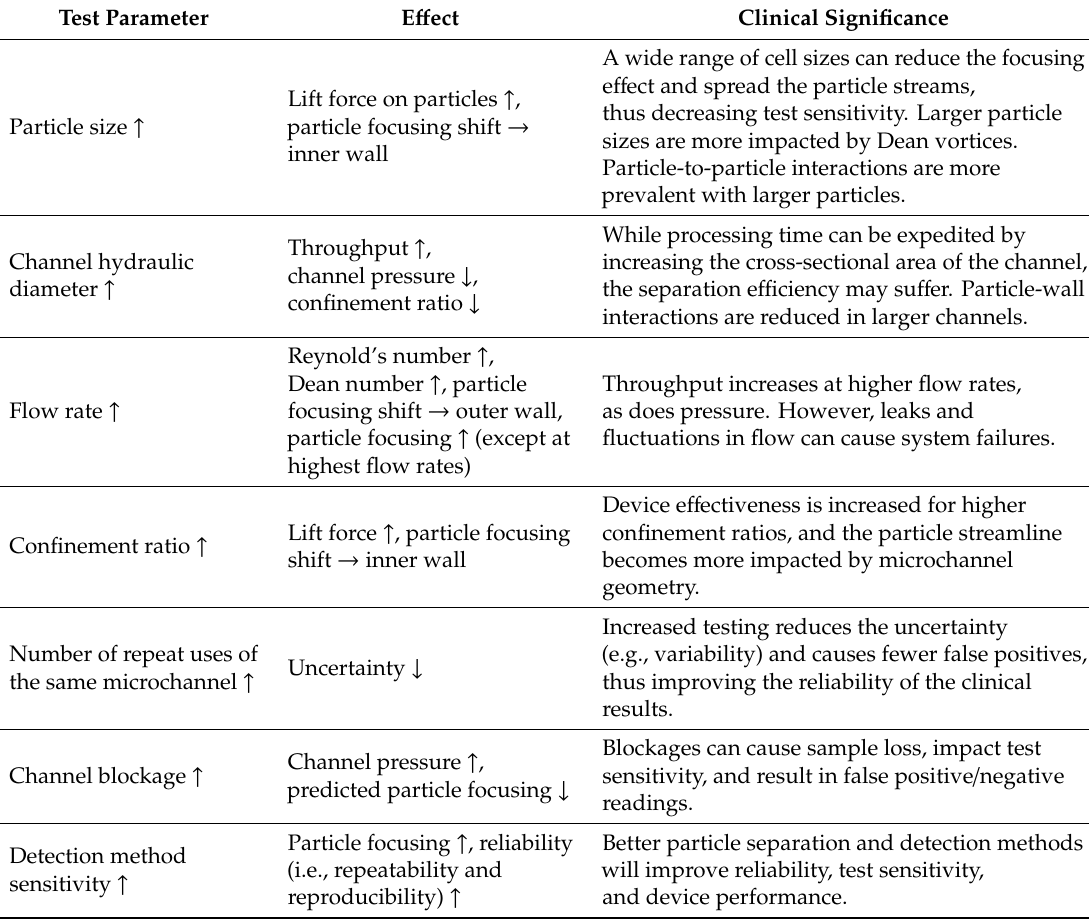
Table 3. Summary of the trends observed in this study and the clinical